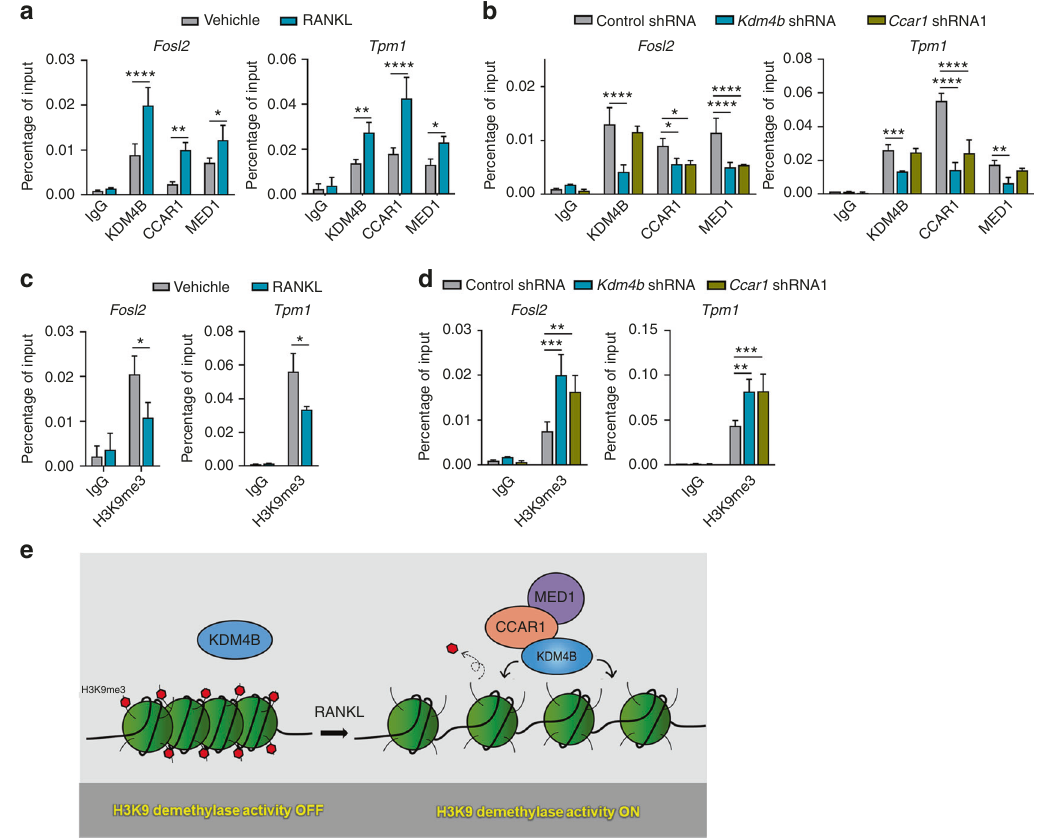
Fig. 5 KDM4B-dependent recruitment of CCAR1 and MED1. a ChIP-qPCR of KDM4B, CCAR1, and MED1 enrichment upon RANKL treatment (100 ng·mL − 1 , 30 min) at the Fosl2 ( − 1.1 kb) and Tpm1 ( − 0.6 kb) promoters . b ChIP assays of KDM4B, CCAR1, and MED1 localization at target genes in cells depleted of KDM4B or CCAR1 upon RANKL signaling (100 ng·mL − 1 , 30 min). c ChIP-qPCR of H3K9me3 in the Fosl2 and Tpm1 promoters in the cells evaluated in ( a ). d ChIP assays of H3K9me3 status in the cells evaluated in ( b ) upon RANKL signaling. e Schematic representation of the cooperative function of KDM4B, CCAR1, and MED1 in regulating H3K9 demethylation. The data are presented as the mean ± SD values of three independent experiments [two-way ANOVA in ( a – d )]. ** P < 0.01; *** P < 0.001. See also Supplementary Fig.